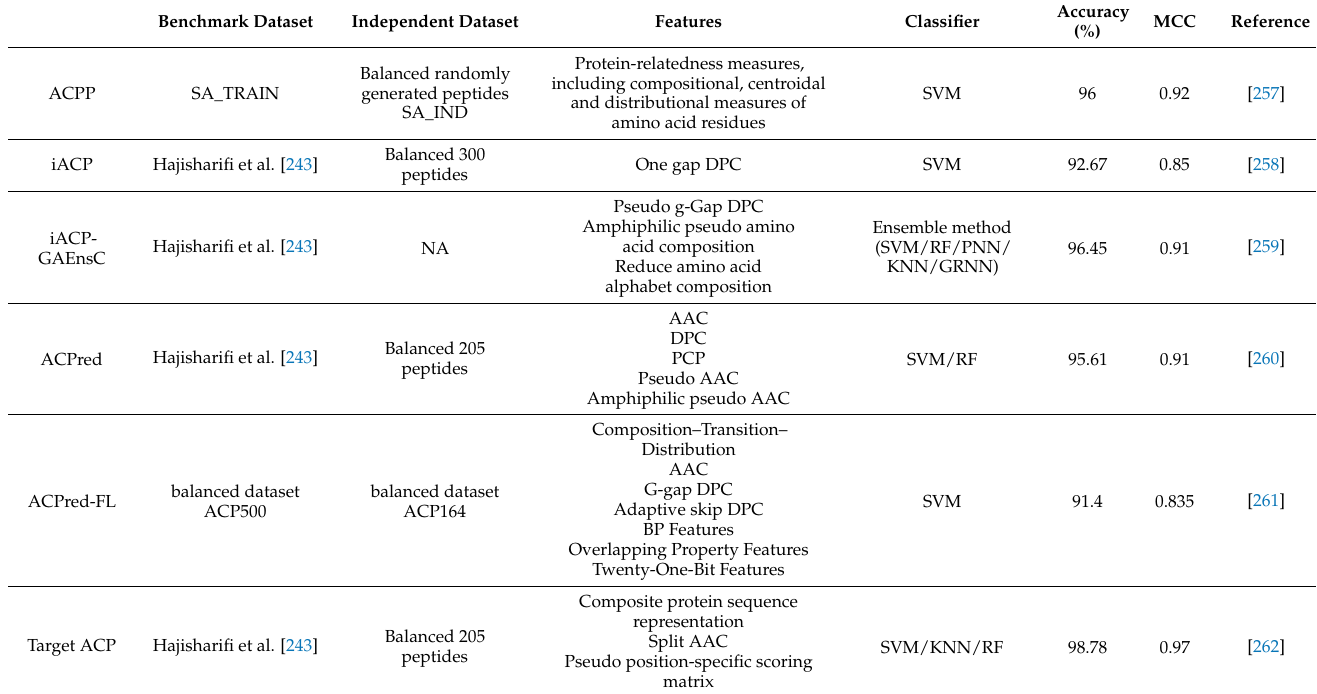
Table 2. Some of the reported traditional ML predictor models showing their types of benchmark and independent datasets, features extracted, classifiers used, accuracy and